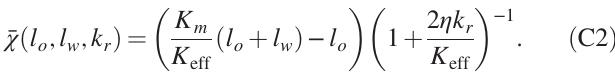
Fig. 6 and agree well with collected data from Langevin simulations. The steady-state solution for l ¼ 0 , i.e., ρ V eff